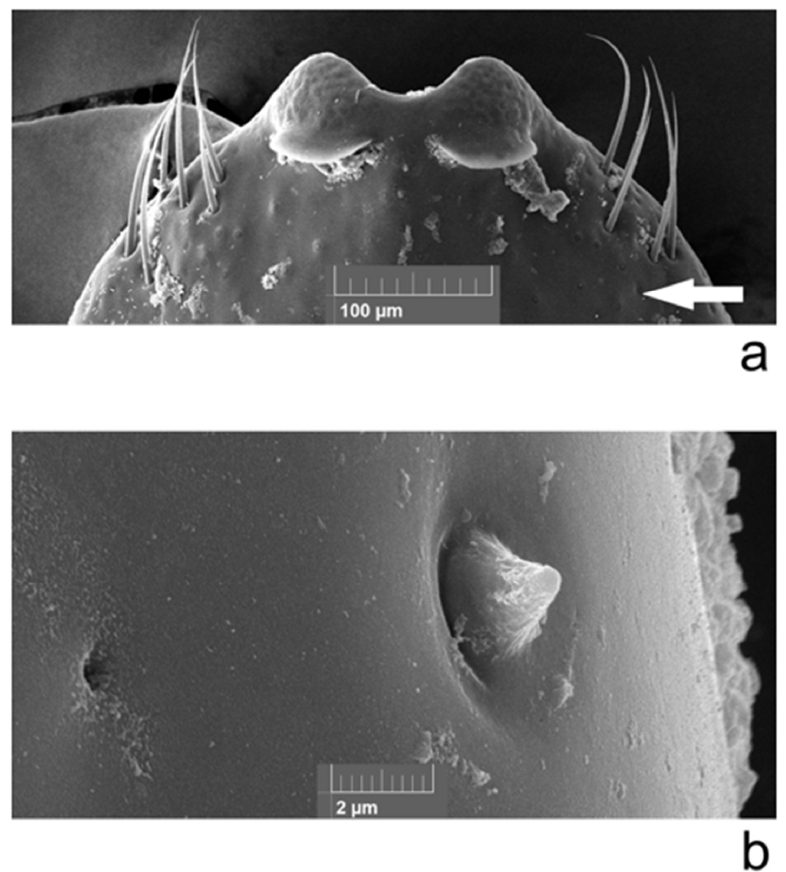
Figure 1. Chrysolina fascinatrix , male aedeagus, ventral view: ( a ) trichoid sensilla (arrow shows location of basiconic sensilla and pores); ( b ) pore ( left ) and basiconic sensilla ( right ). 3.2. Study of the Morphological Variability of Chrysolina Fascinatrix 3.2.1. Number of Punctures in the 5th Elytral Row According to the number of punctures, two groups are distinguished: from 9 to 15 and from 20 to 30 punctures in a row (Figure 2). A difference between females and males is not found.